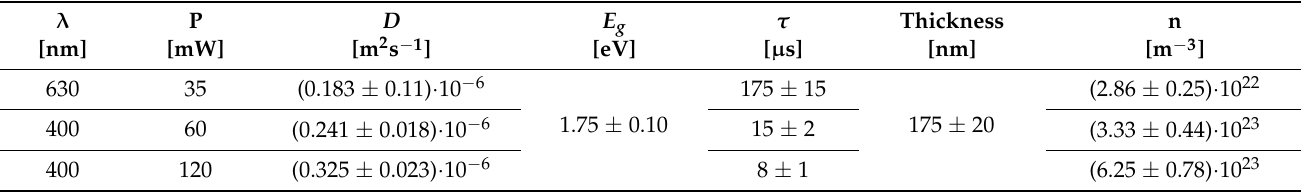
Table 3. Effective parameters of P3HT:PCBM(3:1)+PEDOT:PSS determined by